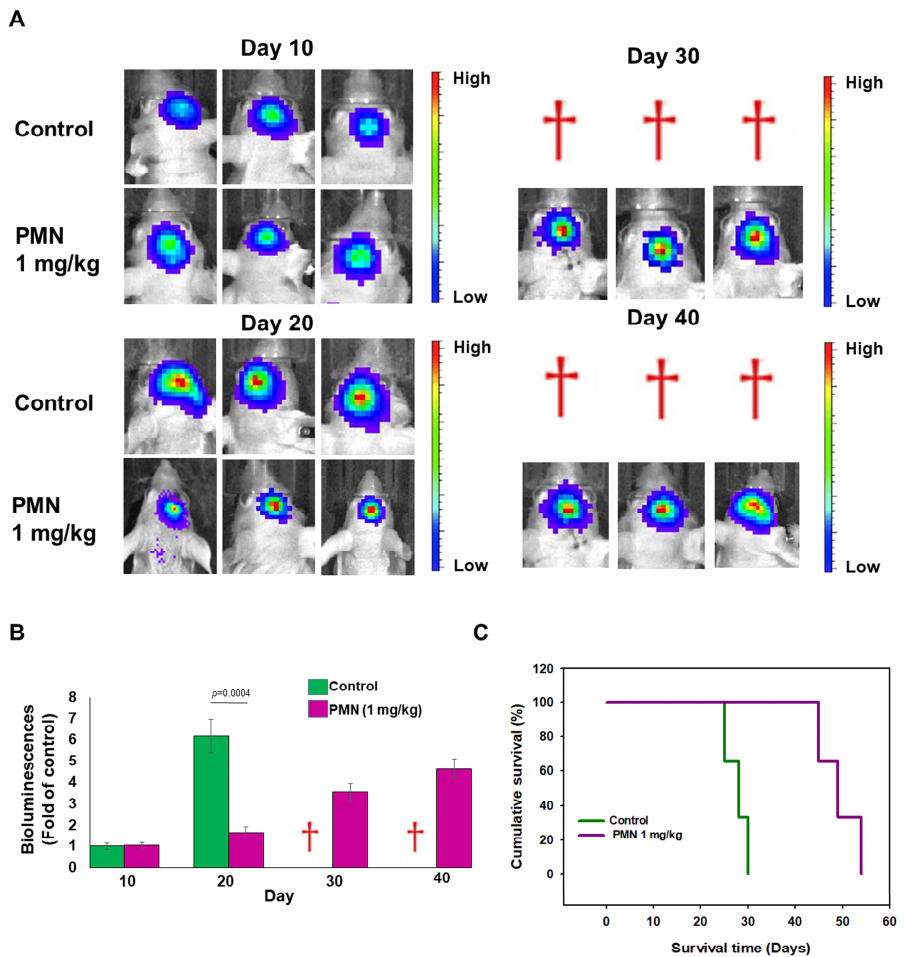
Figure 10. Biophotonic measurements demonstrate the antitumor efficacy of PMN treatment in immunodeficient mice with orthotopic GBM xenografts. U87-luc GBM cells (4 × 10 5 ) were injected intracranially into male BALB/c nude mice (on day 0). Mice were injected intraperitoneally with saline (control group, n = 3) or 1.0 mg/kg PMN ( n = 3) on day 10, day 13 and day 16, respectively. ( A ) Bioluminescence imaging of the cranium of surviving mice at days 10, 20, 30 and 40 after GBM cell implantation. Tumor burden is displayed by a colorimetric scale (function of total irradiance per steradian/s/cm 2 ). The death of mice is represented by a red dagger. ( B ) Comparison of the results for the mean irradiance values for each group in panel A. ( C ) Kaplan—Meier curves of the control and PMN-treated groups show that PMN treatment effectively prolongs the average lifespan of GBM